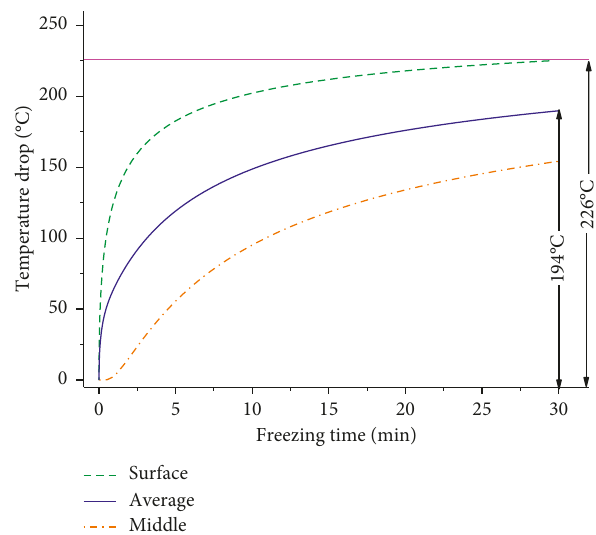
Figure 7: Temperature drop of coal rock with the size of φ 50mm × h 50mm during liquid nitrogen